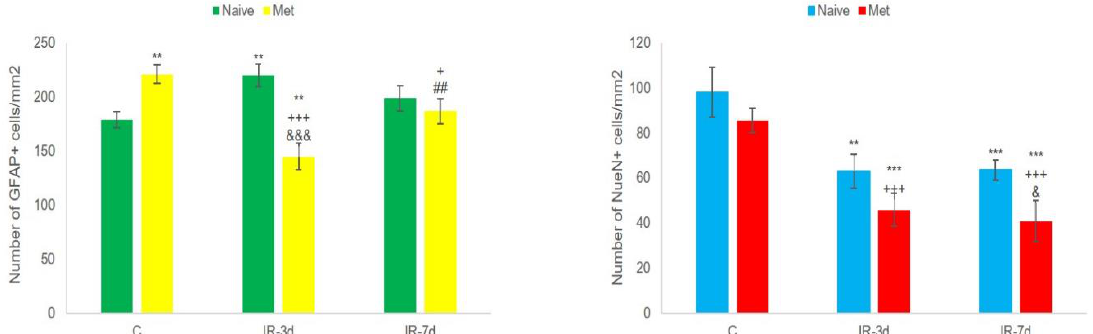
Figure 5. Statistical evaluation of changes in number of NeuN and GFAP positive cells in the CA1 region of the hippocampus. Number of NeuN positive neurons in the CA1 region in naïve control group (C), Met-C, IR-3D, Met-IR-3d, IR-7d and Met-IR-7d ( right ). Number of GFAP positive astrocytes in the CA1 region of the hippocampus ( left ). All results are presented as mean ± SD for n = 5 / group, normalized to the control levels. *** p < 0.001 and ** p < 0.01 versus the control value; +++ p < 0.001 and + p < 0.05 versus the Met-C; ## p < 0.01 versus Met-IR-3d; &&& p < 0.001 and & p < 0.05 versus the groups with the same reperfusion period with / without Met diet pre-treatment.